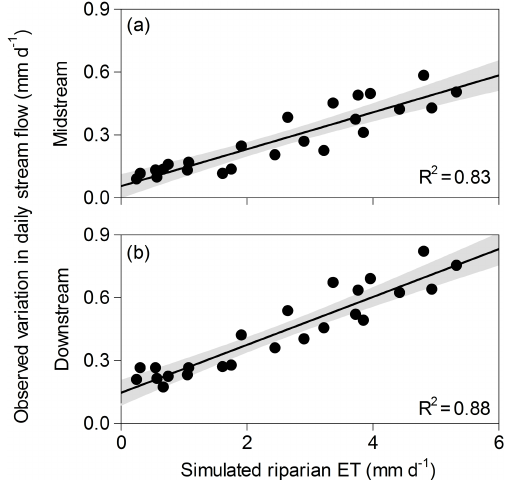
Figure 3. Relationship between monthly mean values of simulated daily riparian evapotranspiration (ET) and observed daily stream- flow variations (used here as an independent proxy of riparian ET) for the (a) midstream and (b) downstream sub-catchments for the calibration period (September 2010–August 2012). Note that simu- lated riparian ET is equivalent in both cases as values are normal- ized by area (i.e., in mm). The linear regression and the 95% confi- dence interval are also shown. For both midstream and downstream sites: p -value < 0 . 001, n = 24. The upstream sub-catchment had no riparian forest and it is not shown.